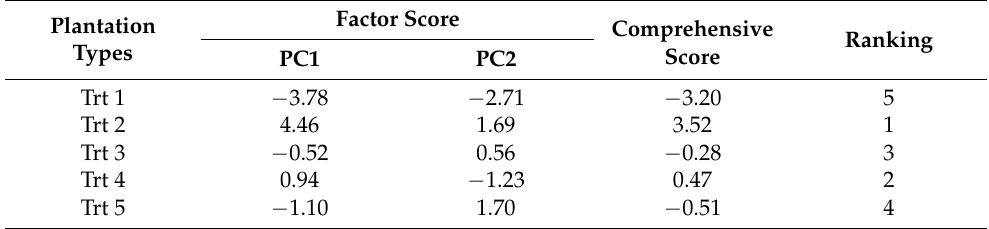
Table 7. Factor score and comprehensive evaluation of Z. planispinum in different planting